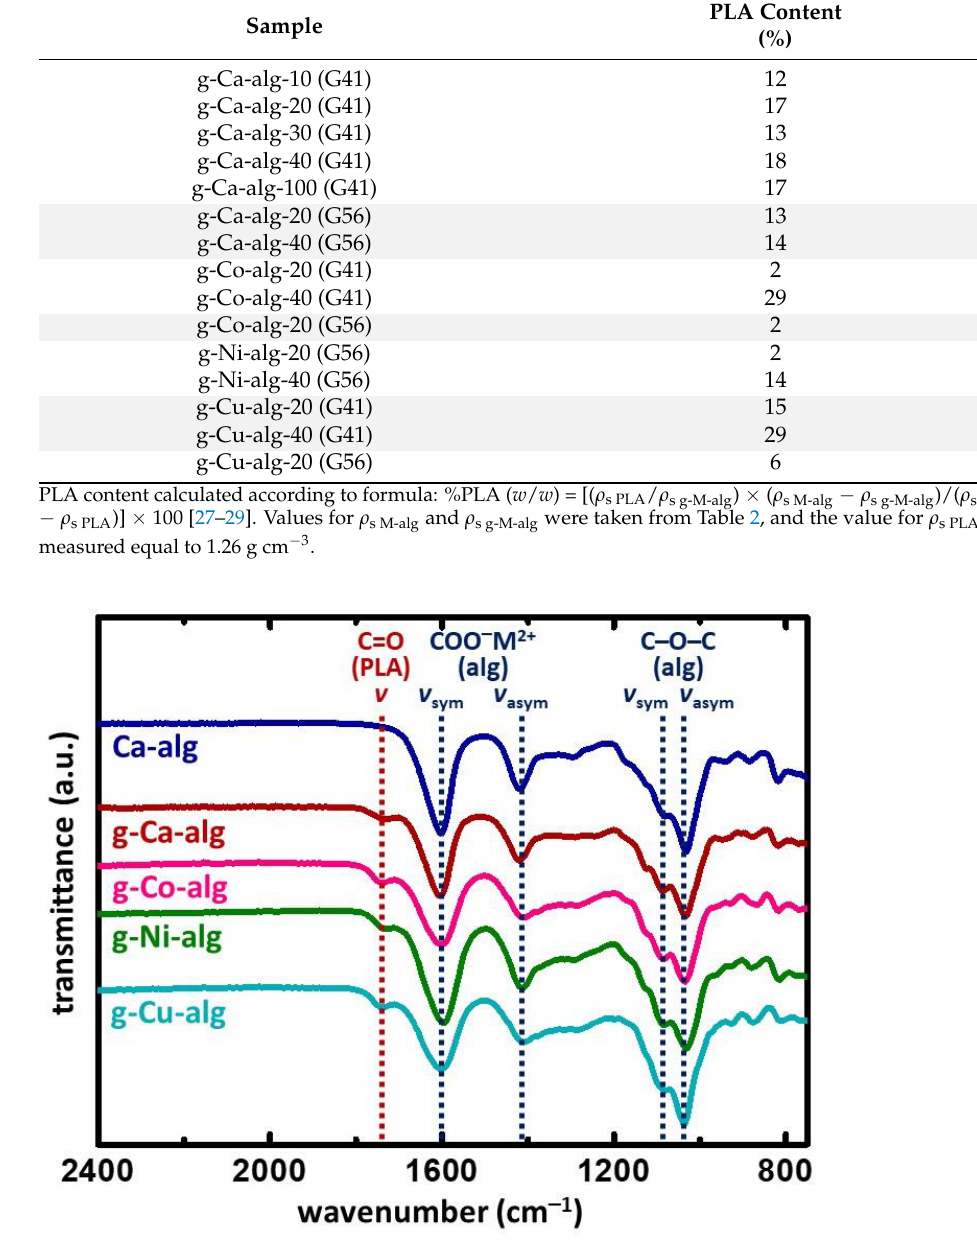
Figure 2. ATR-FTIR spectra of M-alginate and g-M-alginate aerogels, as indicated. Dotted lines mark the bands corresponding to the characteristic vibrations discussed in the text. The PLA content in the aerogels was in the range of 14–29% w / w (see Table 1).